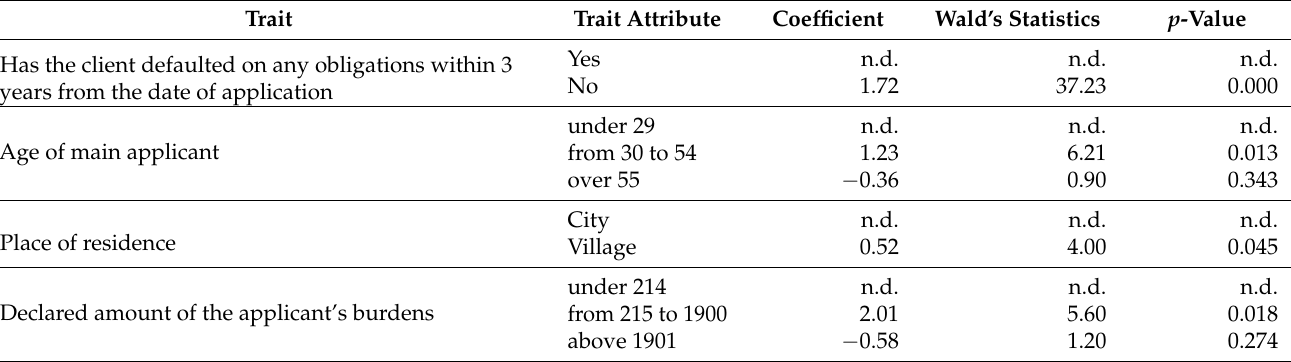
Table 6. Credit risk logit model for Bank B.